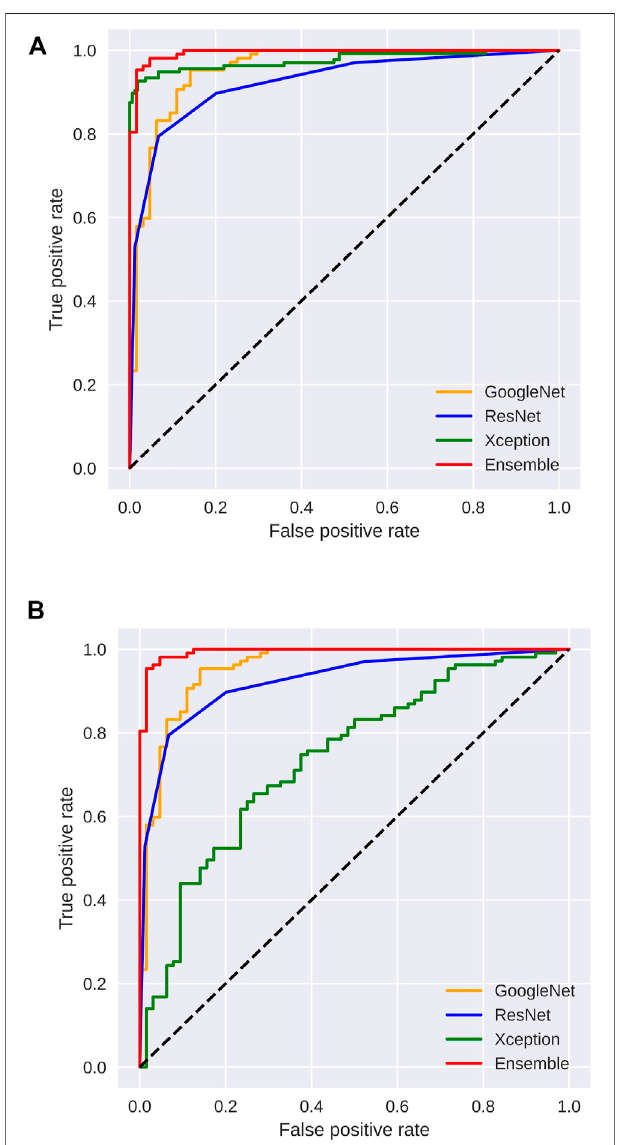
FIGURE 5 | Area under the ROC curve analysis for (A) informative frame detection and (B) cancerous and noncancerous polyp classi fi cation.